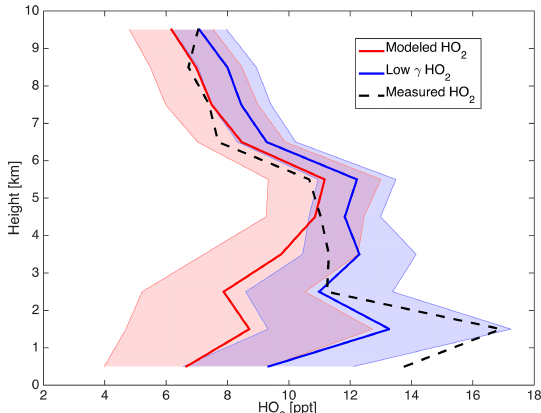
Figure 9. Vertical HO 2 profile for ARCTAS-B flights. Shaded re- gion represents 1 σ of the model ensemble. Blue line and region represents model runs with gamma HO 2 values in the lowest 10% of the uncertainty distribution.